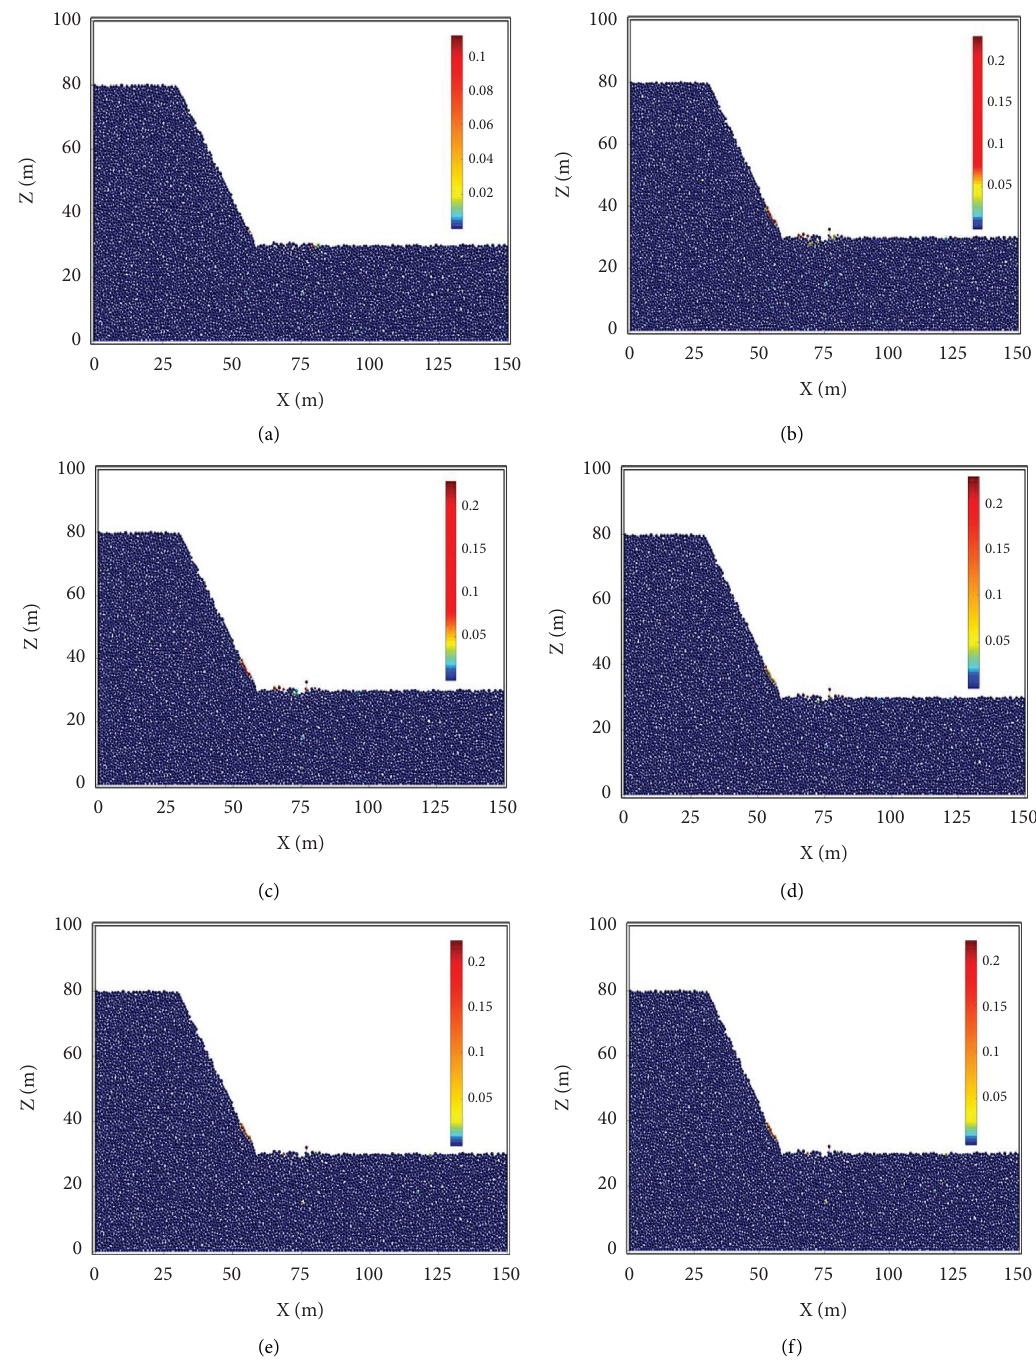
Figure 10: Te efects of diferent ramming times on slope under the tamping energy of 6000kN · m. (a) Te frst time ramming; (b) the second time ramming; (c) the third time ramming; (d) the fourth time ramming; (e) the ffth time ramming; (f) the failure state of